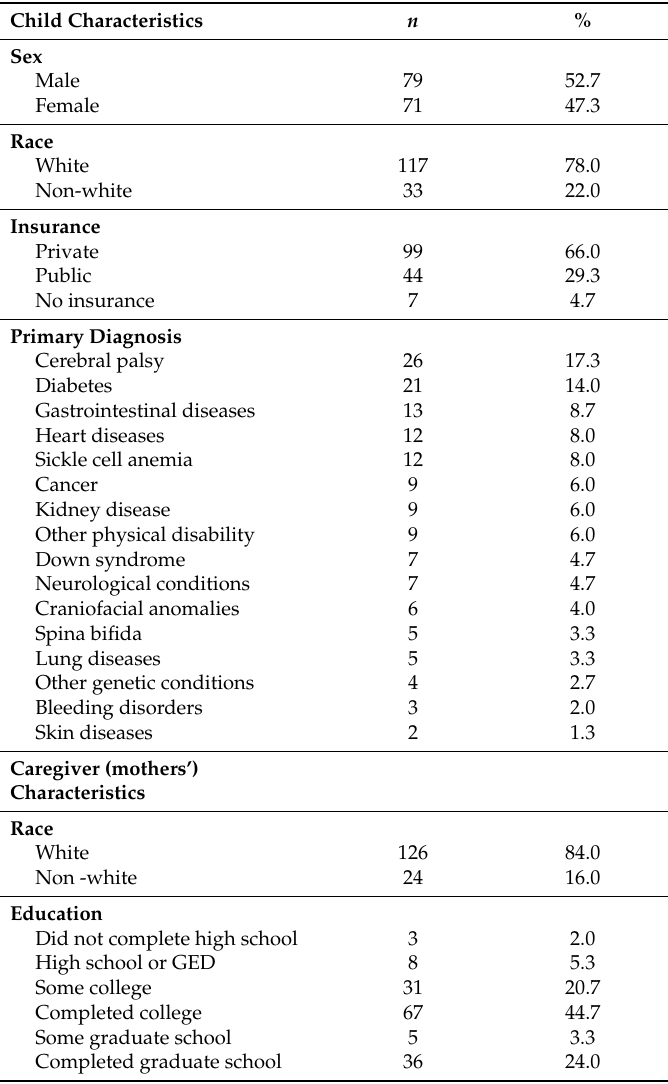
Table 1. Child and caregiver characteristics ( n =